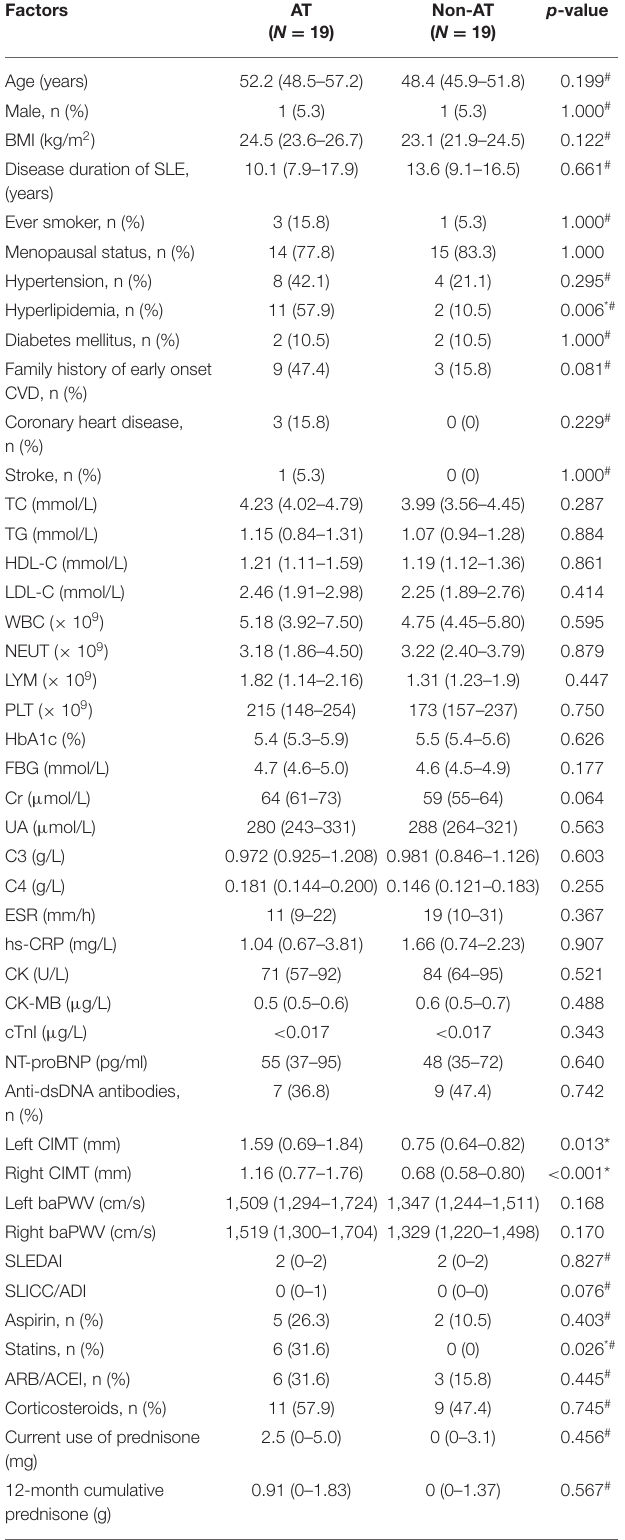
TABLE 1 | Demographics and clinical features of age-matched SLE atheroslerosis and non-atherosclerosis groups.